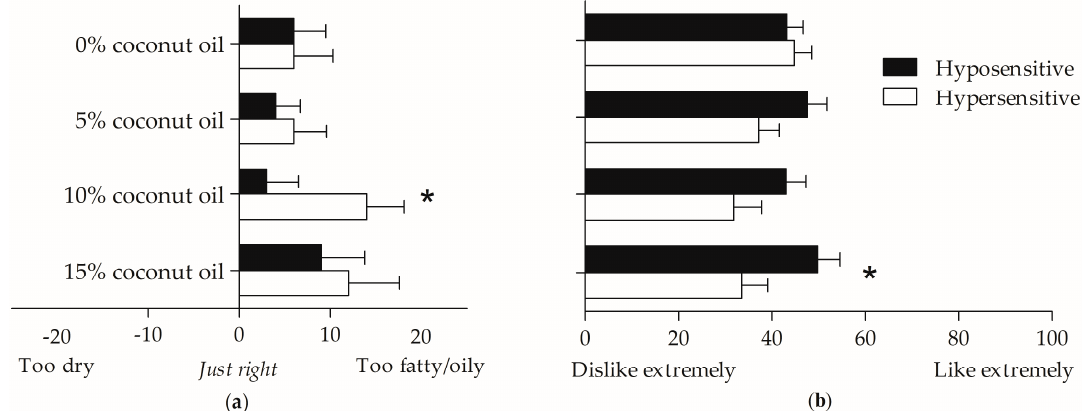
Figure 4. Comparison of ( a ) mouthfeel rating and ( b ) mouthfeel liking of high (15% coconut oil), medium (10% coconut oil), low (5% coconut oil) and no fat custard (0% coconut oil) split by taste hypersensitive ( n = 22) and hyposensitive ( n = 28) participants. Data presented as mean ± sem. * p < 0.05.